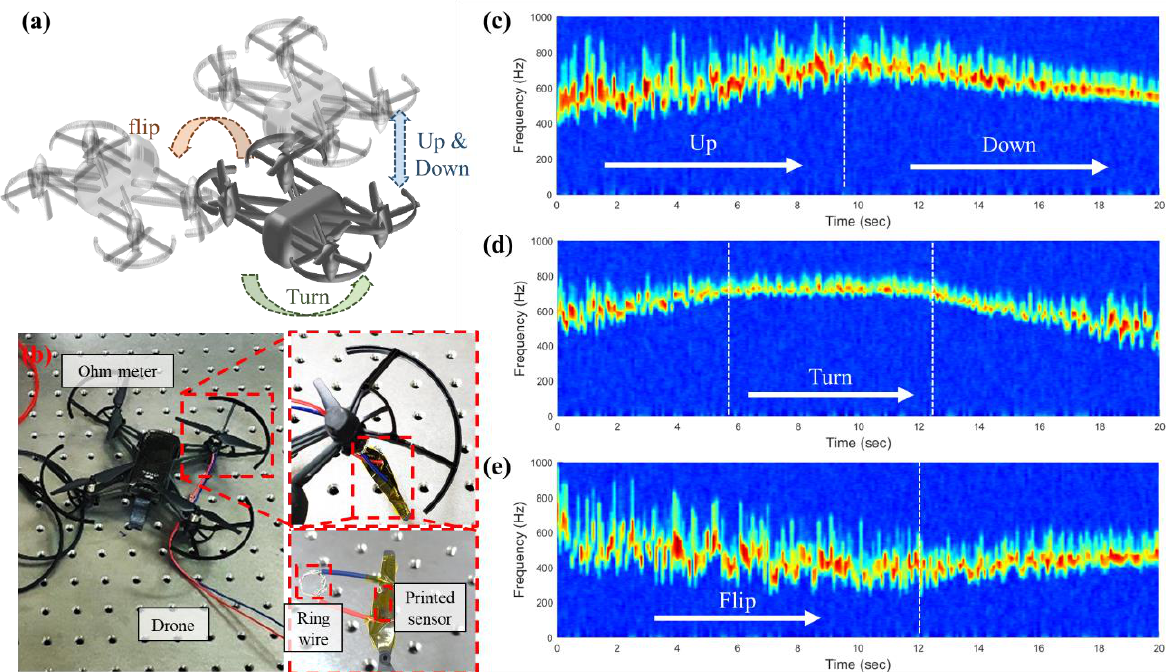
Figure 4. ( a ) Schematic illustration of drone and its motion including up and down, turn, and flip. ( b ) Photograph of experimental setup for rotor blade monitoring. Time-frequency plots of measured resistance with motion of ( c ) up and down, ( d ) turn, and ( e ) flip.